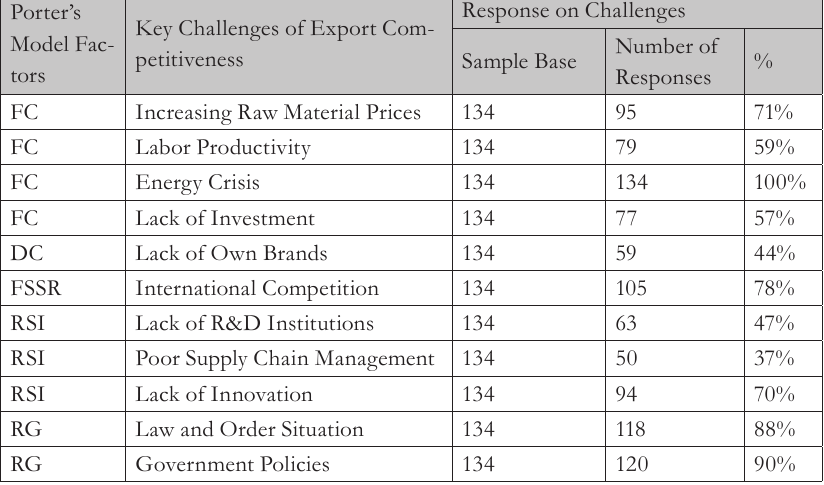
Tab. 2 – Key Challenges of Export Competitiveness of RMG Industry of